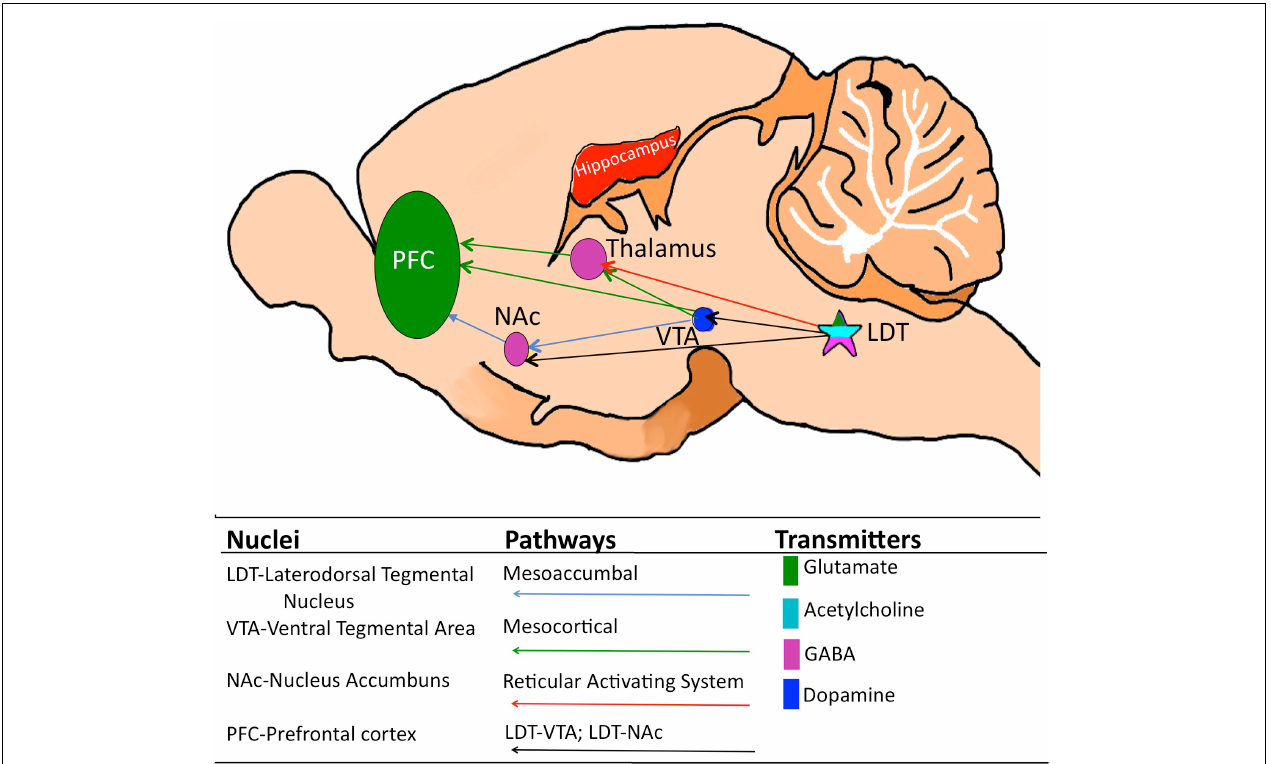
FIGURE 1 | Cartoon of the mouse brain showing relevant corticothalamic, mesoaccumbal and mesocortical pathways and, while not an exhaustive list, the relevant key neuronal phenotypes. The laterodorsal tegmentum (LDT) which is comprised of glutamate, GABA and acetylcholine-containing neurons is located in the pons and sends projections to a multiplicity of brain sites, including the thalamus, the ventral tegmental area (VTA) and the nucleus accumbens (NAc). Via these projections, the LDT governs arousal associated with learning and memory and motivated behaviors, including drug seeking behavior, as well as cortical electrical signatures of